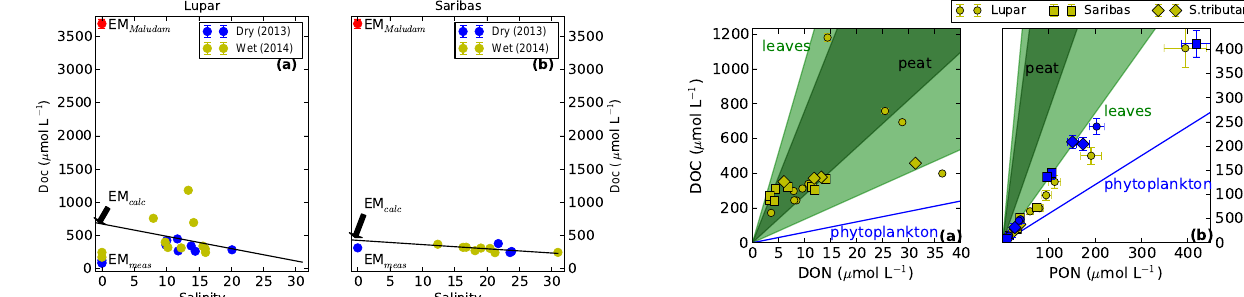
Figure 3. Dissolved organic carbon (DOC) concentrations vs. salin- ity in the Lupar (a) and Saribas (b) estuaries. The red marker refers to the zero salinity end-member in the peat-draining tributaries. The line indicates the DOC-salinity regression line; labels refer to theo- retical and measured end-member values as described in the text.